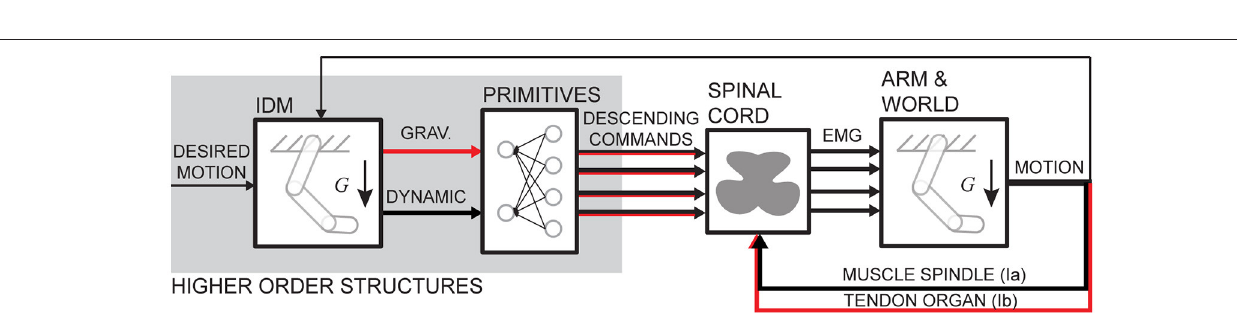
FIGURE 8 | Schematic of a motor control schema. Red arrows indicate signals potentially containing gravitational command components. Overlapping arrows indicate hybrid signals. IDM stands for inverse dynamic model, indicating a potential embedded limb dynamics.